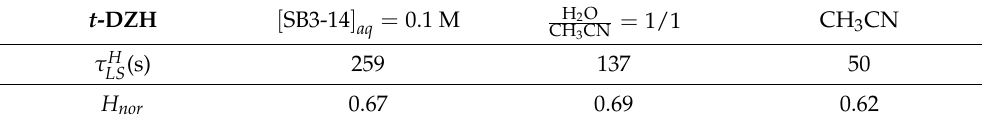
) of c -DZH determined in the three media by fitting the thermal isomerization Table 4. Lifetimes ( τ H LS kinetics of Figure 4A through the function of Equation (12) and the least-squares method. Normalized fuzzy entropy H nor for c -DZH in the three media, determined by using the output of MEM. t